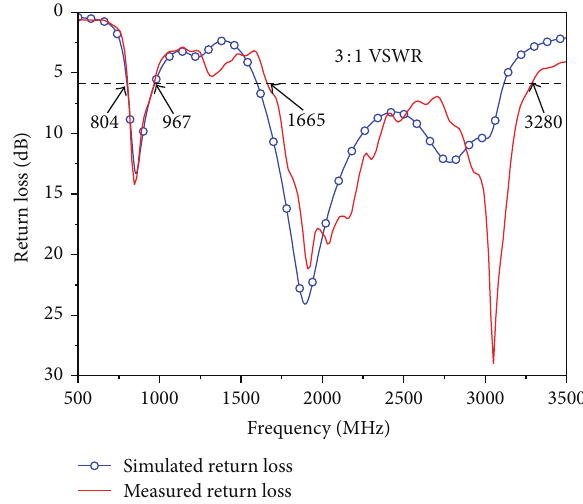
Figure 7: Measured and simulated return loss for the fabricated